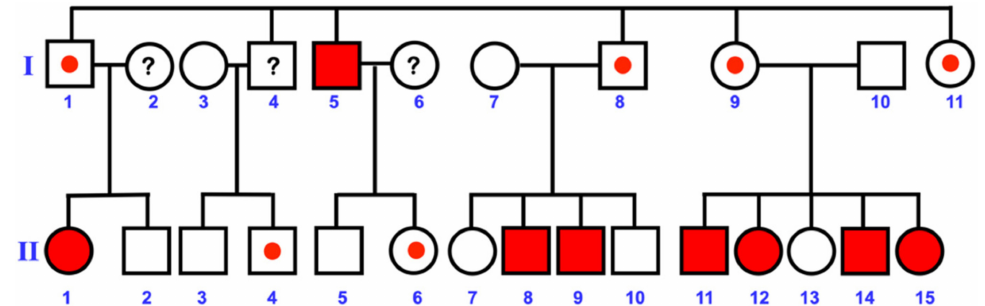
Figure 1. Pedigree of the two-generation Hmong family (Family 1). This family consists of 26 members, of which eight are affected with mesiodens (block red) and 18 are unaffected (white). Red dots represent non-penetrant individuals who have the variant p.Glu603Lys but not mesiodens. A number of the affected are children of the non-penetrant. Family members I-2, I-4, I-6, and II-1 were not available for genetic study. The phenotypes of the parents of I-1, I-4, I-5, I-8, I-9, and I-11 are